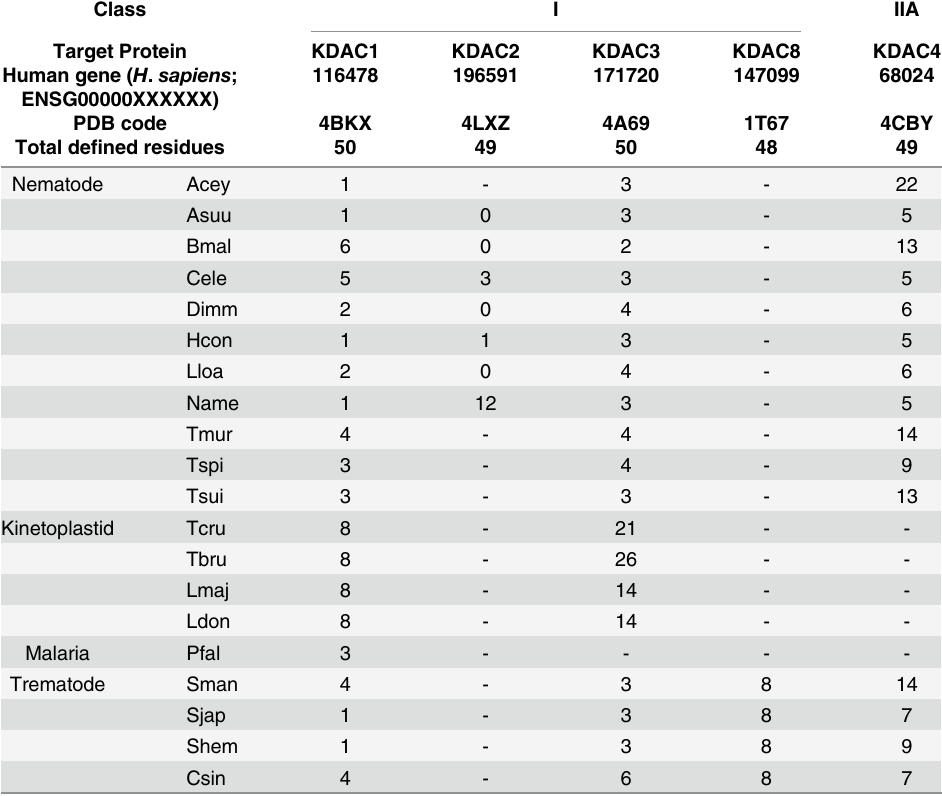
Table 3. Sequence variations of KDAC proteins of parasitic species in comparison with the host ( H . sapiens ) orthologs at the active sites. Active-site residues were defined as any residue with a distance less than 10 Å to the catalytic zinc in the crystal structure. Abbreviations were used for the names of all the species following the rule of “ the first letter of genus + first three letter of species ” .